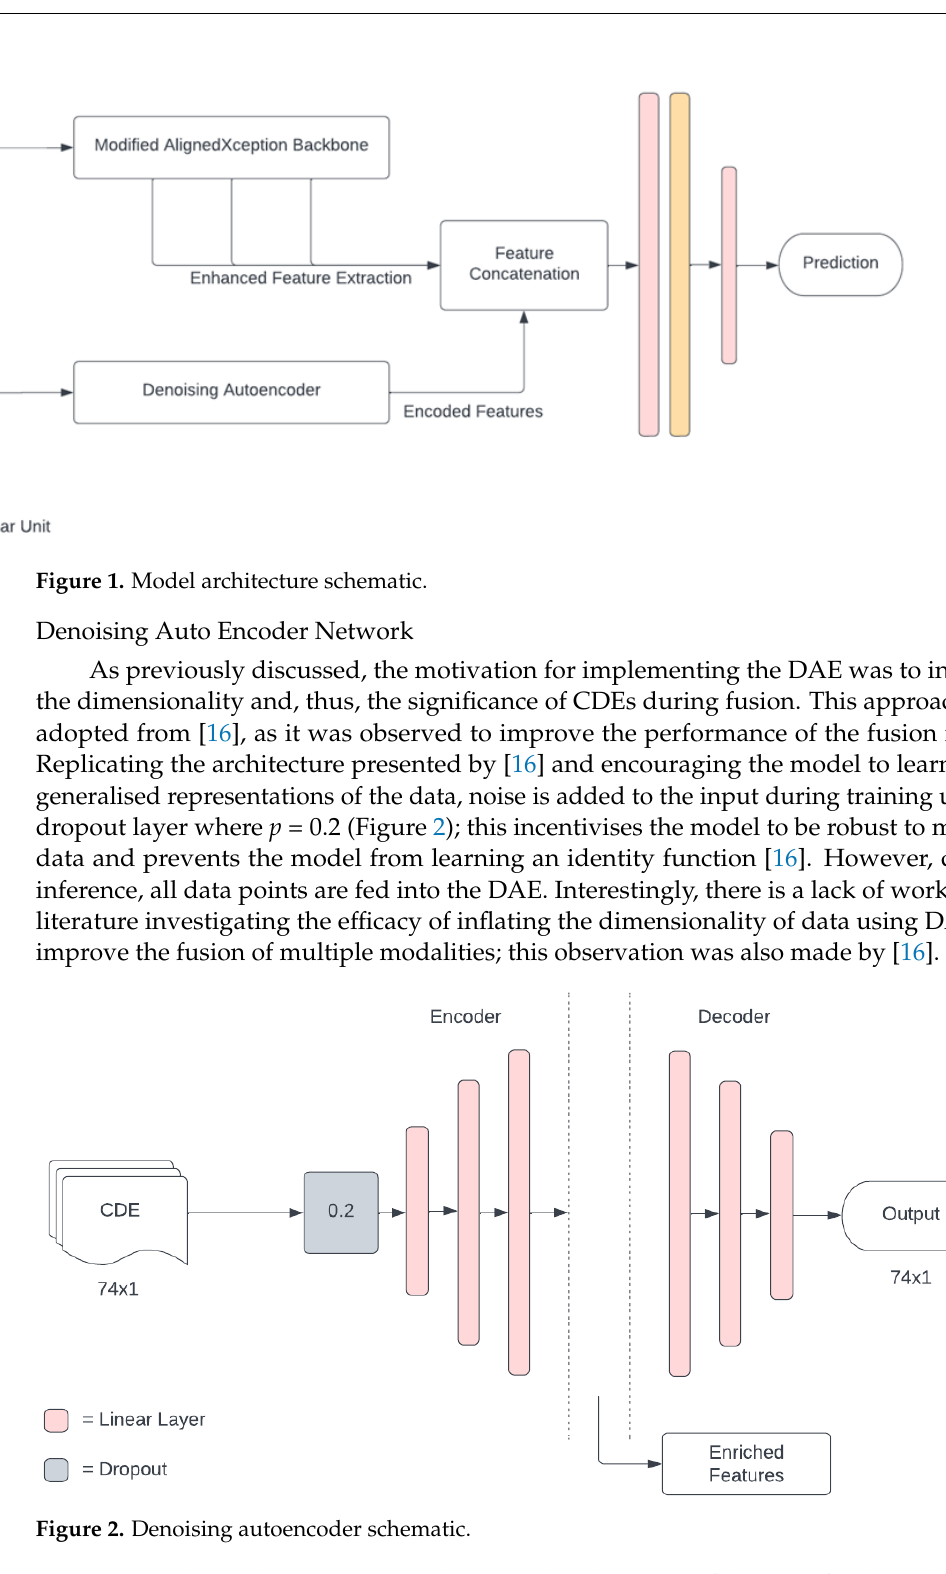
Figure 2. Denoising autoencoder schematic.